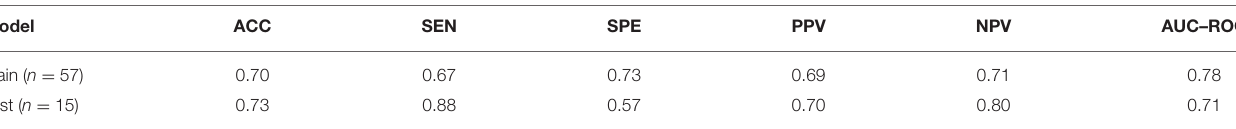
TABLE 3 | Prediction outcome summary.